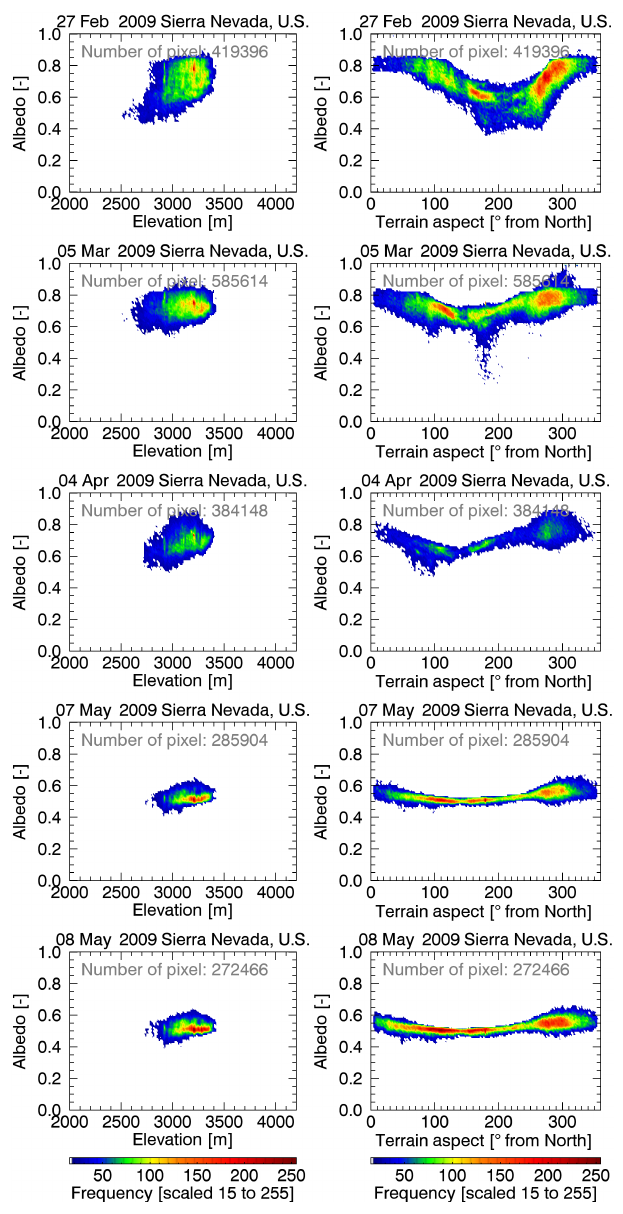
Figure 12. Snow albedo with respect to terrain elevation (left panels) and terrain aspect (right panels) in the Sierra Nevada in spring 2009.